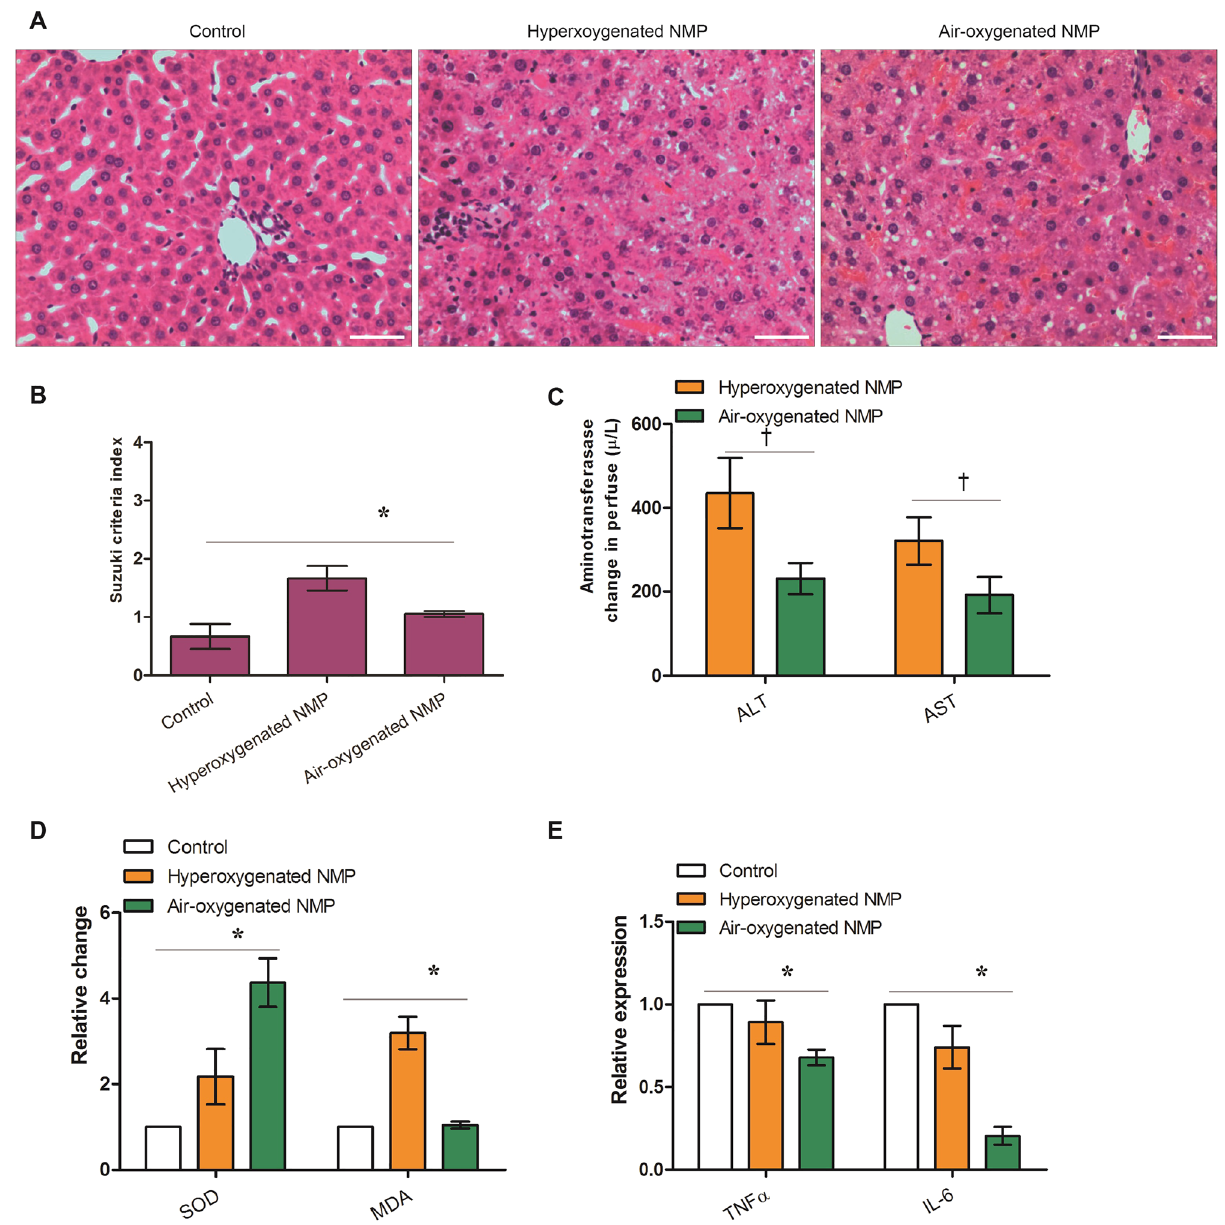
Figure 1. Air-oxygenated normothermic machine perfusion (NMP) confers a better functional recovery in rat liver from donation after cardiac death (*denotes significant differences among control, air-oxygenated NMP and hyperoxygenated NMP, P < 0.05; n = 6). ( A ) Histology (hematoxylin and eosin staining) of the perfused livers (hematoxylin counterstaining, original magnification × 200, and scale bars 50 μm); ( B ) uzuki sinusoidal injury score of the perfused livers on a scale from 0 to 4; ( C ) Changes in levels of ALT and AST in the NMP perfusate; ( D ) Relative changes in SOD activity and MDA level in the perfused livers; ( E ) Relative levels of inflammation factors, TNF-α and IL-6, in the liver performed using